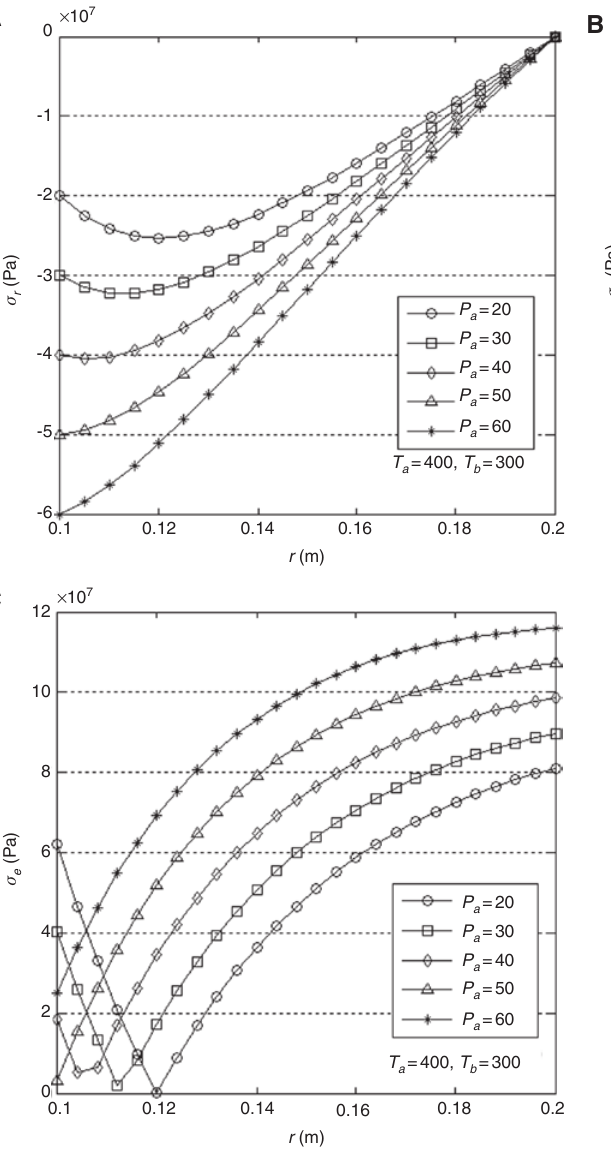
Figure 6: Distribution of the (A) radial, (B) circumferential and (C) effective stresses in an FG cylinder subjected to different quantities of internal pressure and constant T